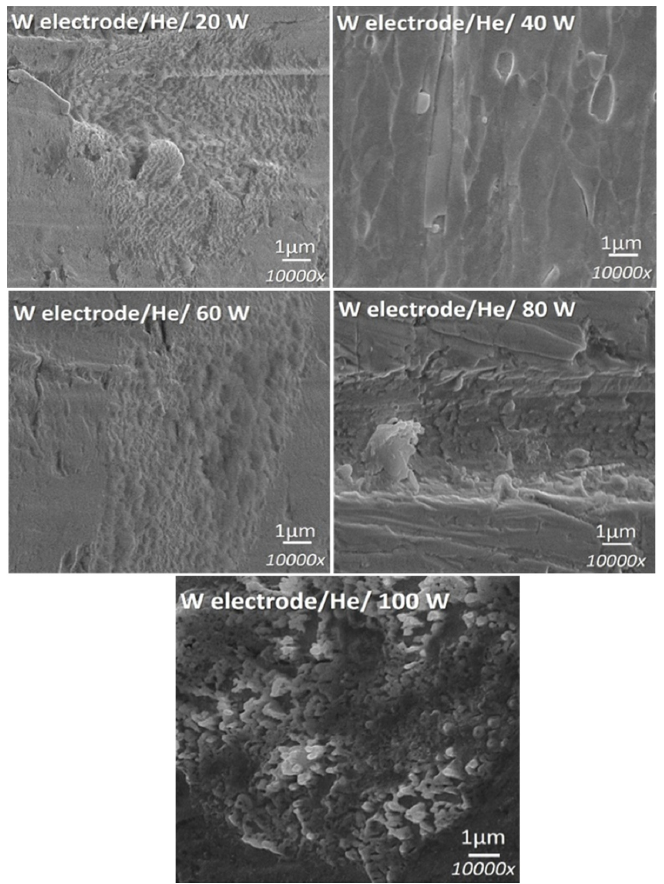
Figure 7. SEM images of W surface electrodes exposed to atmospheric pressure He-MD for 20 W–100 W.